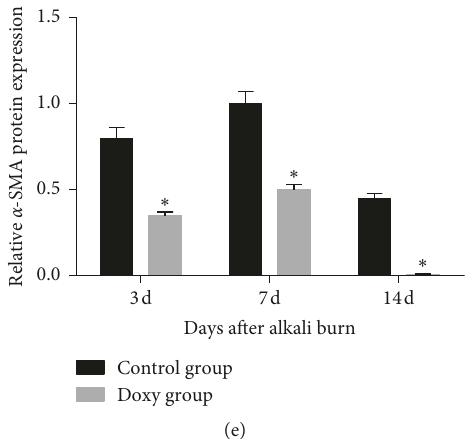
Figure 6: Western blot of the relative expression of transforming growth factor- β 1 (TGF- β 1), nuclear factor-kappa B (NF- κ B), and anti- α -smooth muscle actin ( α -SMA) protein. The expression of these three proteins in the doxycycline group was significantly decreased compared to that in the control group 3, 7, and 14 days after chemical injury ( P < 0 . 05). ∗ Statistically significant; data are expressed as mean ± SD, n �